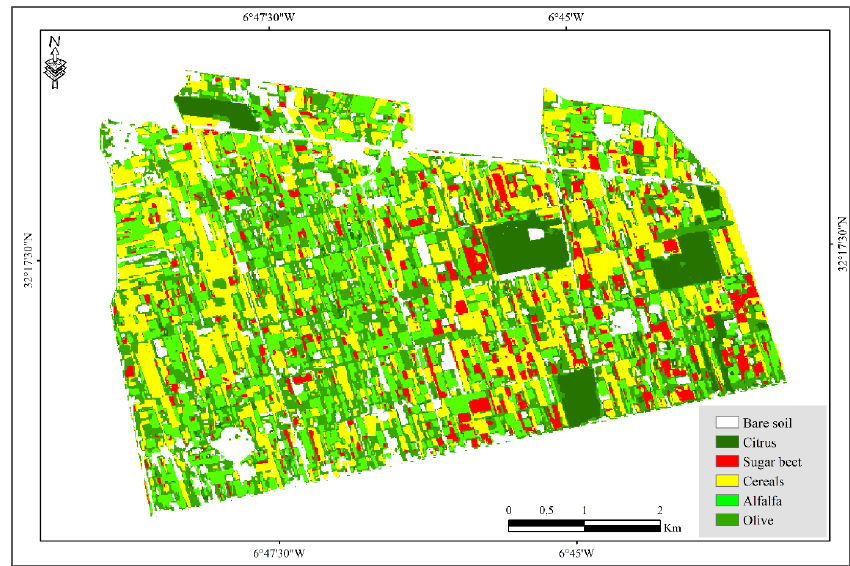
Figure 7. Crop type map of the study area.